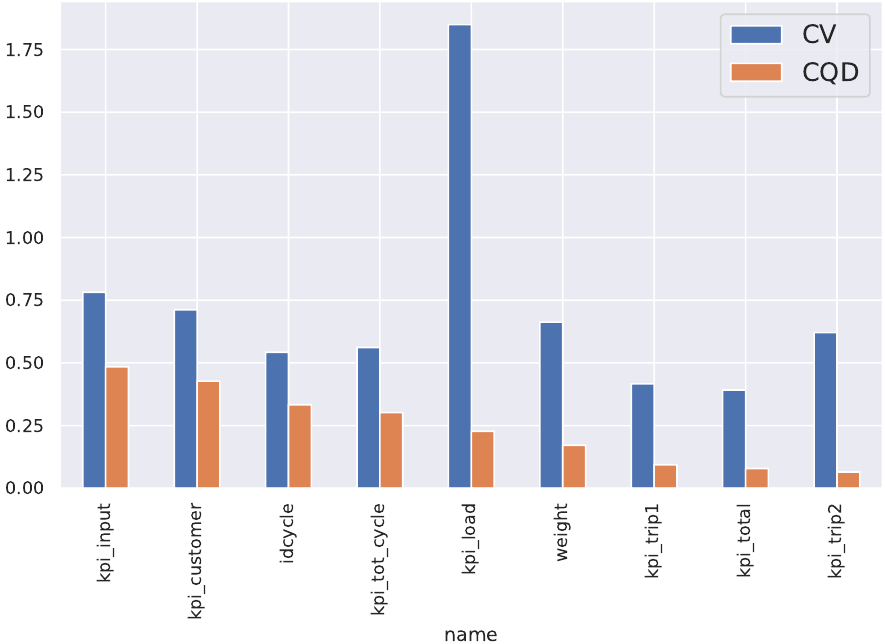
Figure 2. CV and CQD per variable in case study 1. Units for CQD are same that for original variables (see Table